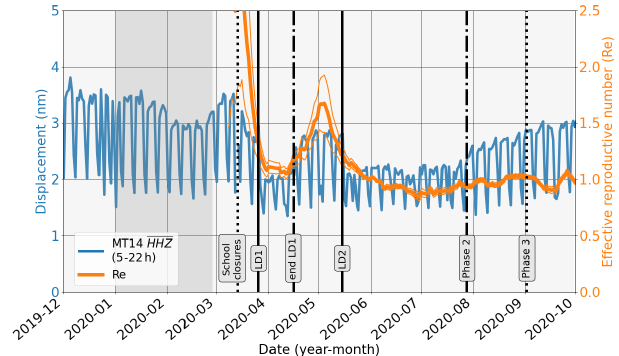
Figure 7. Comparison between noise evolution of station MT14 (blue line) and the epidemiological factor of the effective repro- ductive number (Re) over time is shown (orange line) with 95% confidence intervals (thin orange lines). The vertical black lines in- dicate the time of public restrictions implemented in Las Condes. The grey background between January and March corresponds to the summer holiday season in